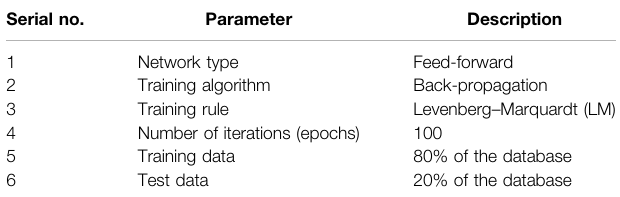
TABLE 8 | ANN parameters set for calculating the number of nodes in the hidden layer (H n